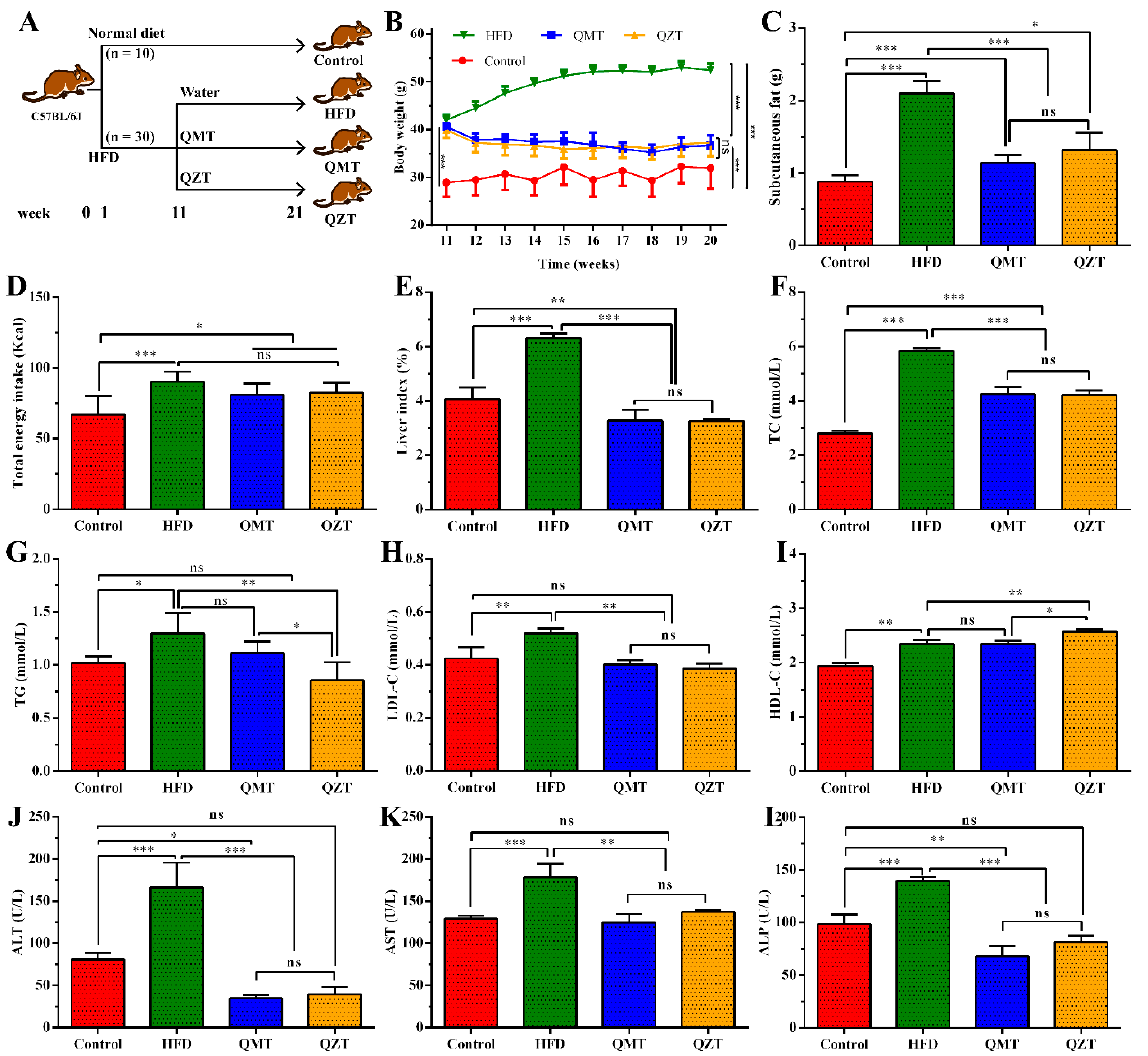
Figure 1. Effects of QMTe and QZTe supplementation on HFD-induced obesity and metabolic dis- orders. ( A ) Schematic overview of the experimental design. ( B ) The body weight in each group of mice during the 10-week tea intervention. The subcutaneous fat weight ( C ), total energy intake ( D ), liver index ( E ), and the serum levels of TC ( F ), TG ( G ), LDL-C ( H ), HDL-C ( I ), AST ( J ), ALT ( K ), and ALP ( L ) in each group of mice after the 10-week tea intervention. TC, total cholesterol; TG, triglyc- erides; LDL-C, low-density lipoprotein cholesterol; HDL-C, high-density lipoprotein cholesterol; AST, aspartate aminotransferase; ALT, alanine aminotransferase; ALP, alkaline phosphatase.